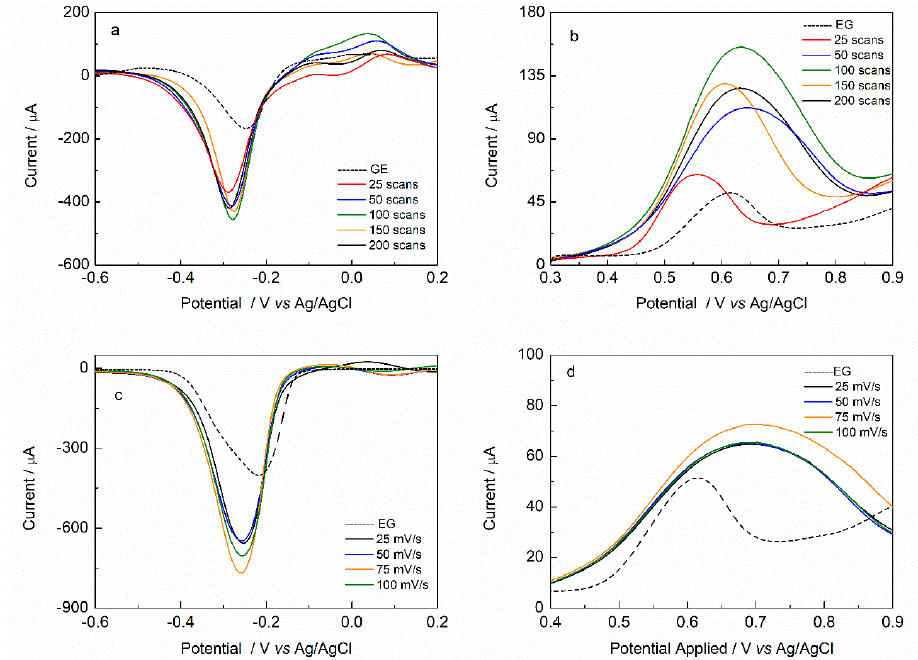
Figure 5. Differential pulse voltamograms recorded in a 0.10 M phosphate buffer solution, pH 7.60 of poly(4-HPA)/GE. ( a – c ) Methylene blue reduction containing probe and ( b – d ) Ethidium bromide oxidation containing probe + target. Amplitude: 25 mV; pulse period: 0.20 s; pulse height: 0.06 s; and ν = 20 mV/s. (---) DPV for GE.